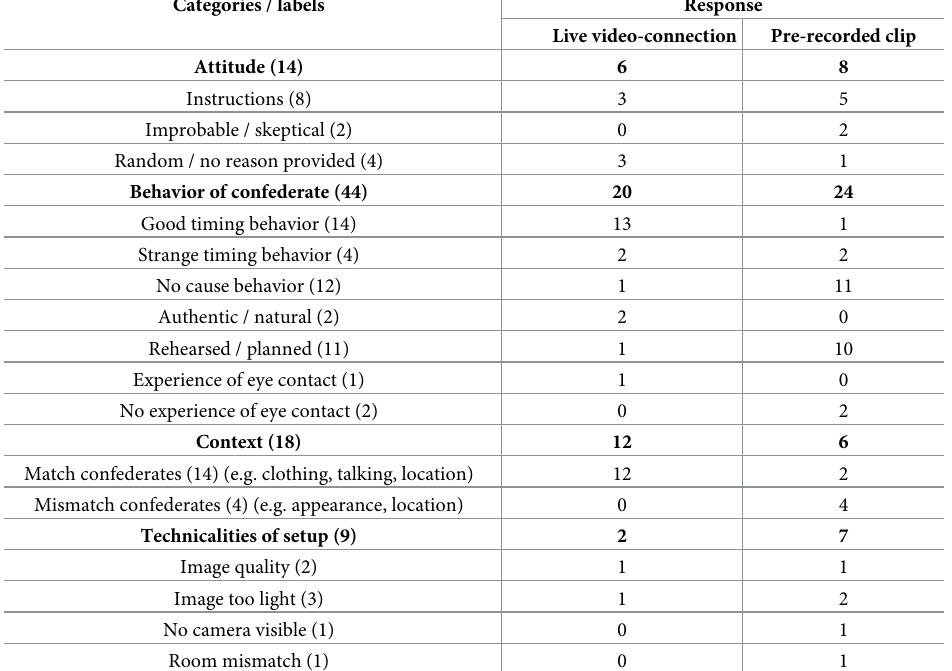
Table 2. Coding scheme for first-person responses (N =